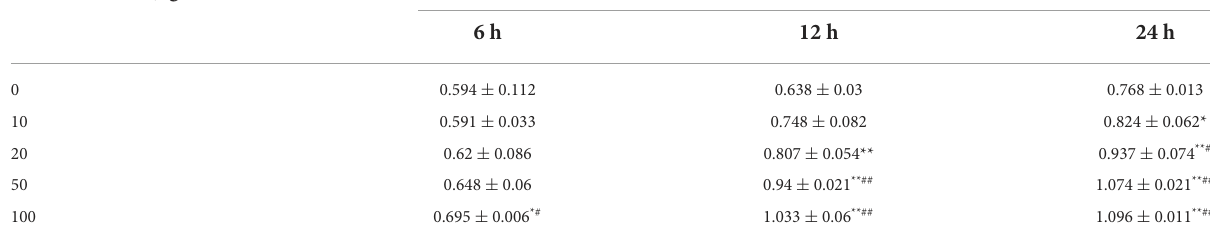
TABLE 2 Effect of ellagic acid on IPEC cell proliferation.